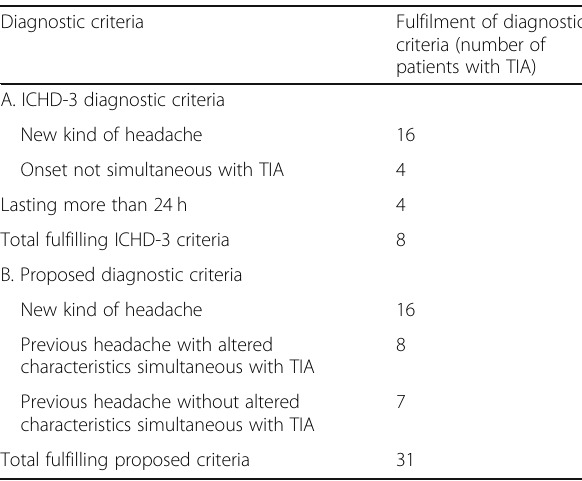
Table 1 Fulfilment of ICHD-3 diagnostic subcriteria and proposed subcriteria for headache attributed to TIA Diagnostic